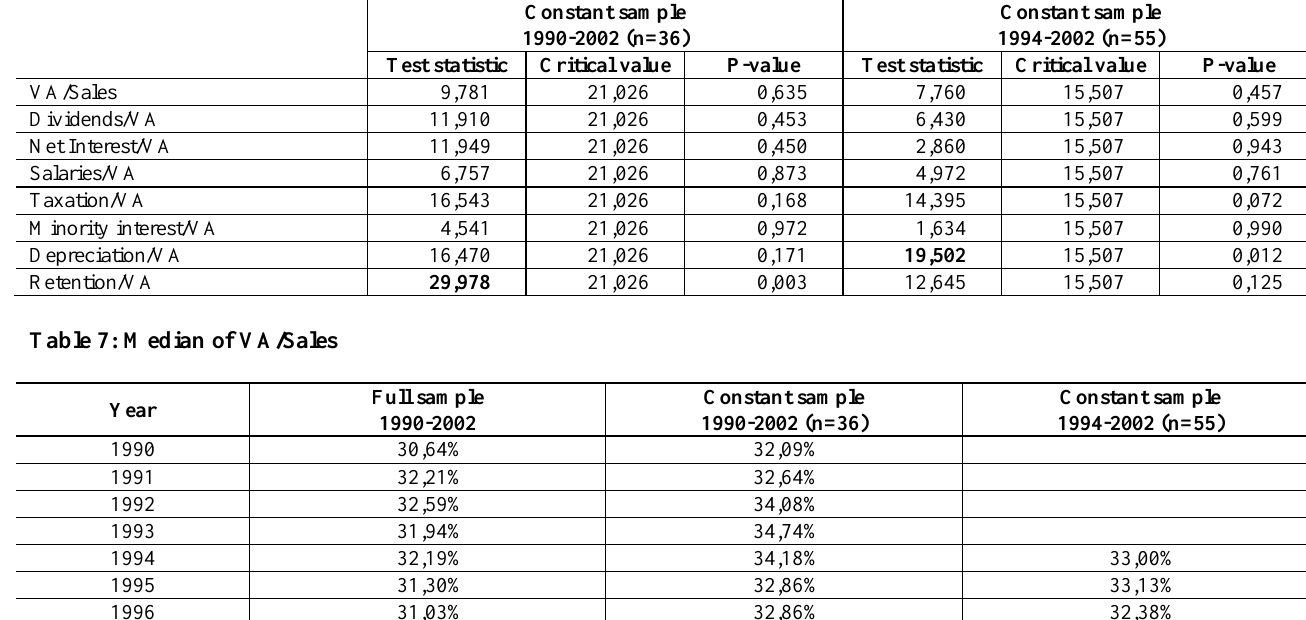
Table 6: Results of Kruskal-Wallis test performed on all VA distribution ratios – constant samples